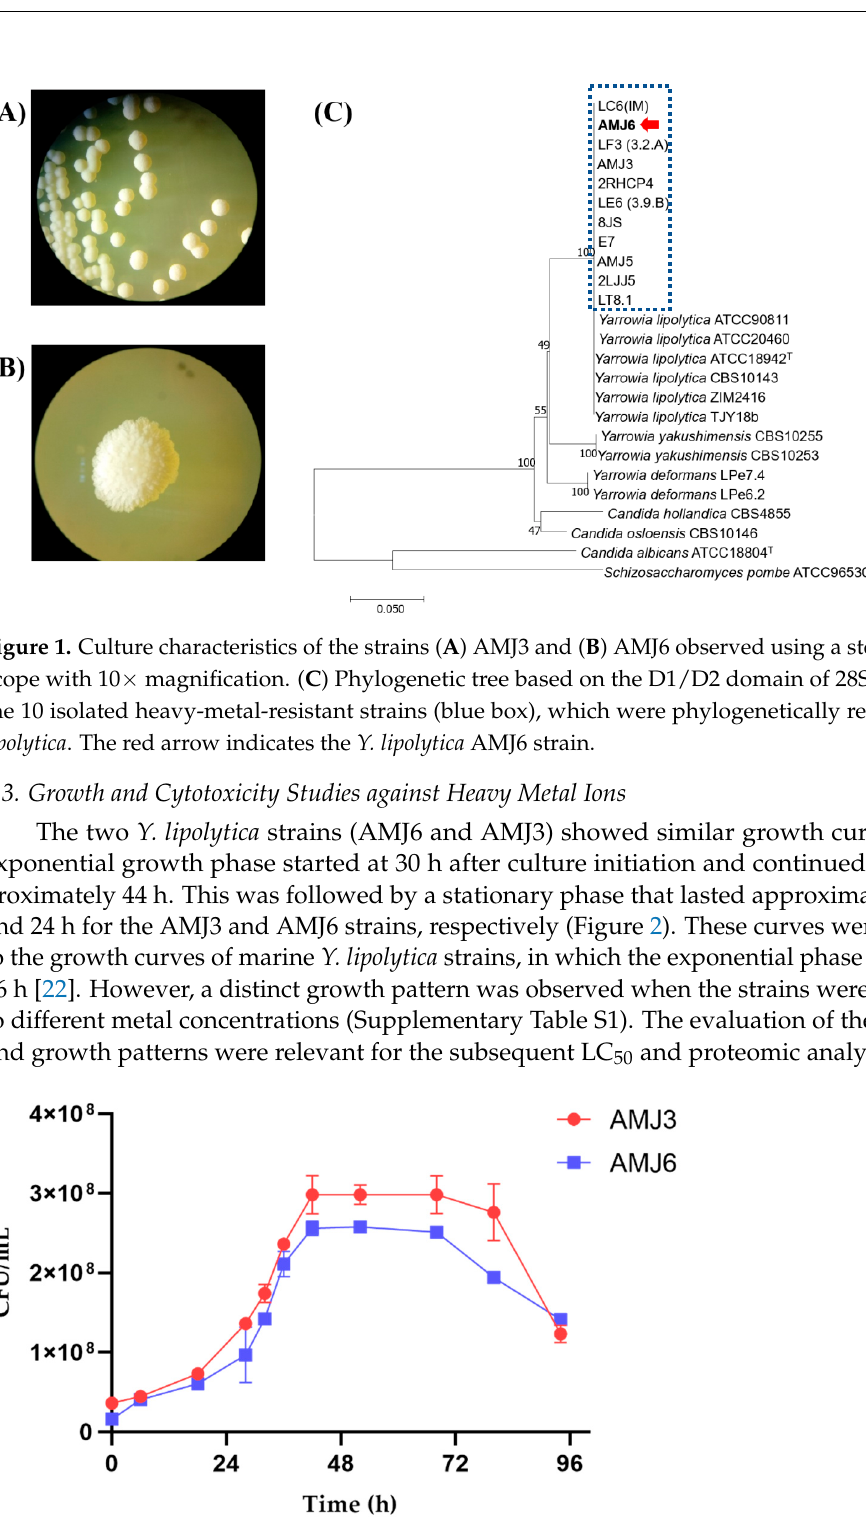
Figure 2. Growth curves of the Y. lipolytica AMJ3 and AMJ6 strains in YPG medium, at a temperature of 20 ◦ C and with constant agitation at 150 rpm. The growth was measured over 96